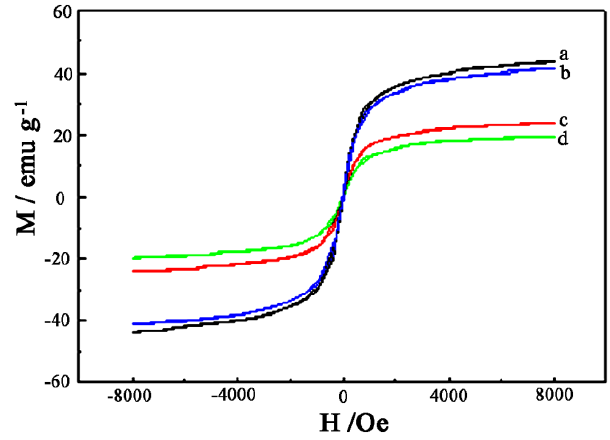
Figure 6. The magnetic hysteresis plots for γ-Fe 2 O 3 /PANI-curcumin with different molar ratios between γ-Fe 2 O 3 /PANI and curcumin: a, γ-Fe 2 O 3 /PANI; b, 2:1; c, 1:2 and d,